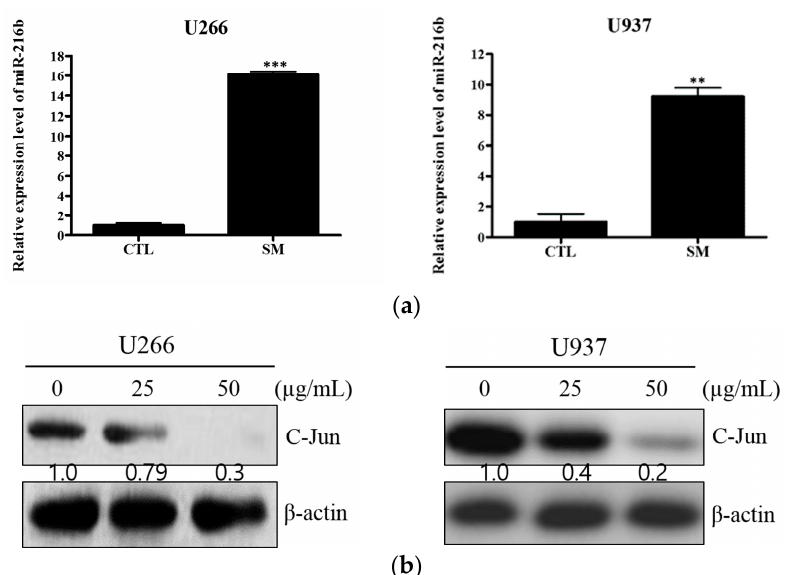
Figure 5. SM increases the expression of miR-216b and represses its target c-Jun. ( a ) In U266 and U937 cells, miR-216b levels were measured by a real-time PCR assay after 24 h of SM (50 µg/mL) treatment. Values represent the means of three experiments ± SD; **, p < 0.01; ***, p < 0.001 versus an untreated control; ( b ) U266 and U937 cells were treated with SM (25 or 50 µg/mL) for 24 h and Western blot analysis was assayed for expression of c-Jun and β -actin.